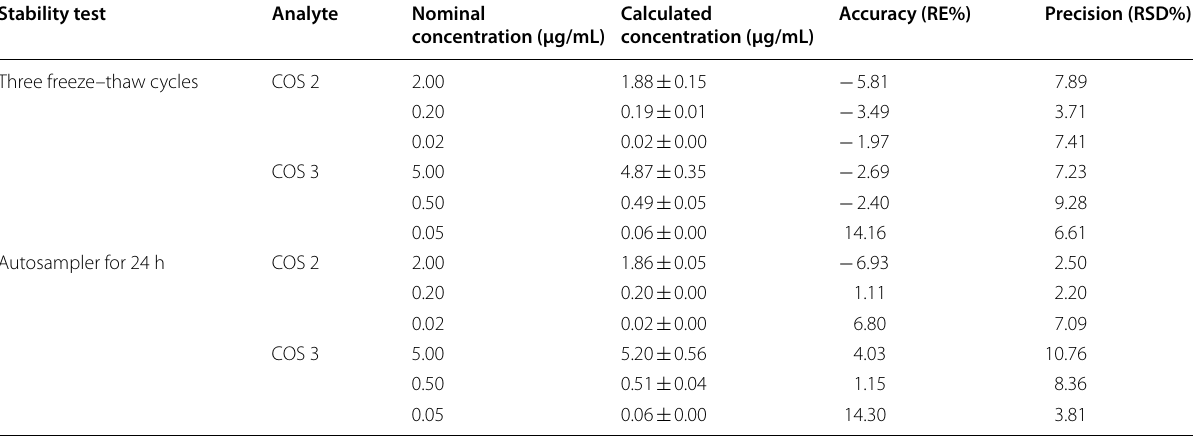
Table 4 Stability results of COS 2 and COS 3 under two different storage conditions Stability test